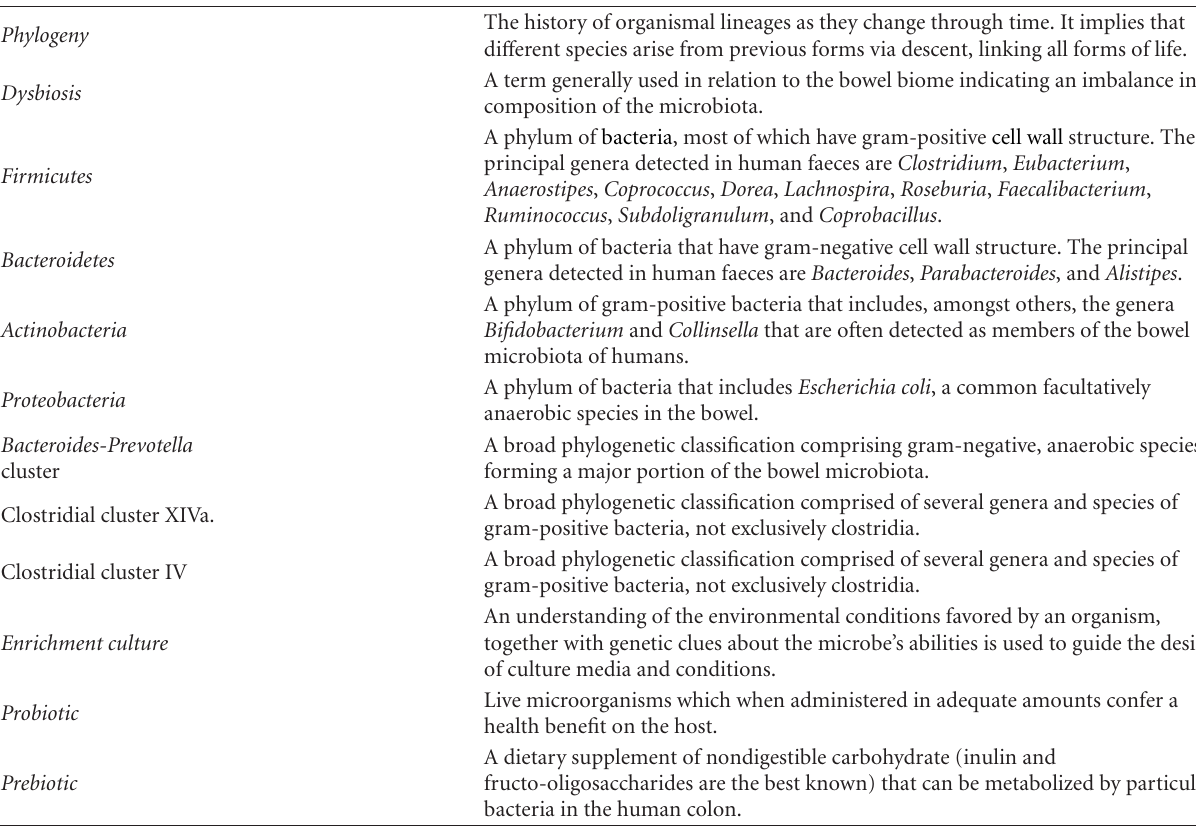
Table 1: Common terms used in bowel microbial